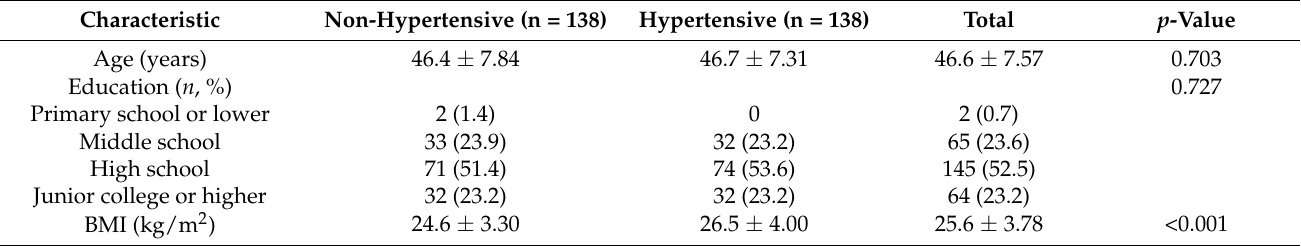
Table 1. General characteristics among the study population (n =